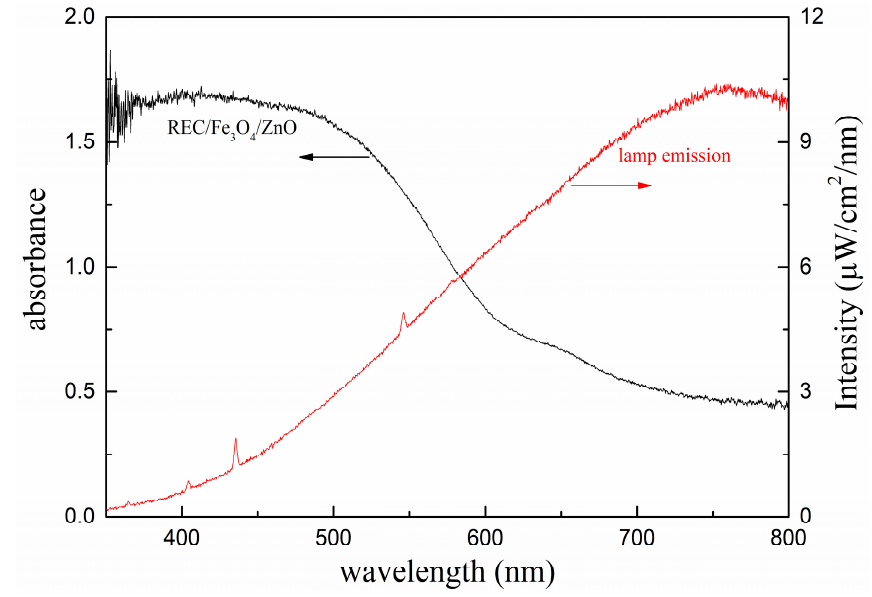
Figure 11. Absorption spectrum of REC/Fe 3 O 4 /ZnO (1:0.3:0.5) and the irradiance of lamp using in this study.